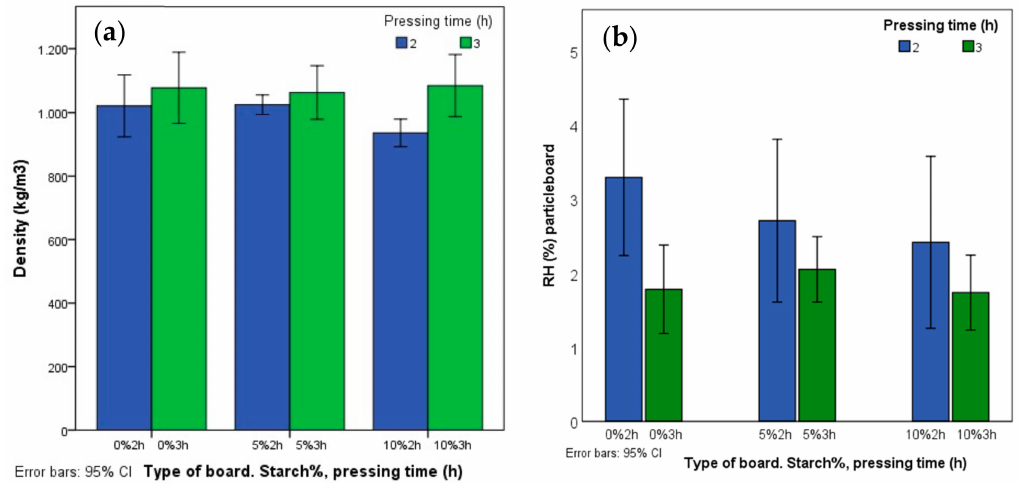
Figure 4. Mean density ( a ) and relative humidity (RH) ( b ) according to type of